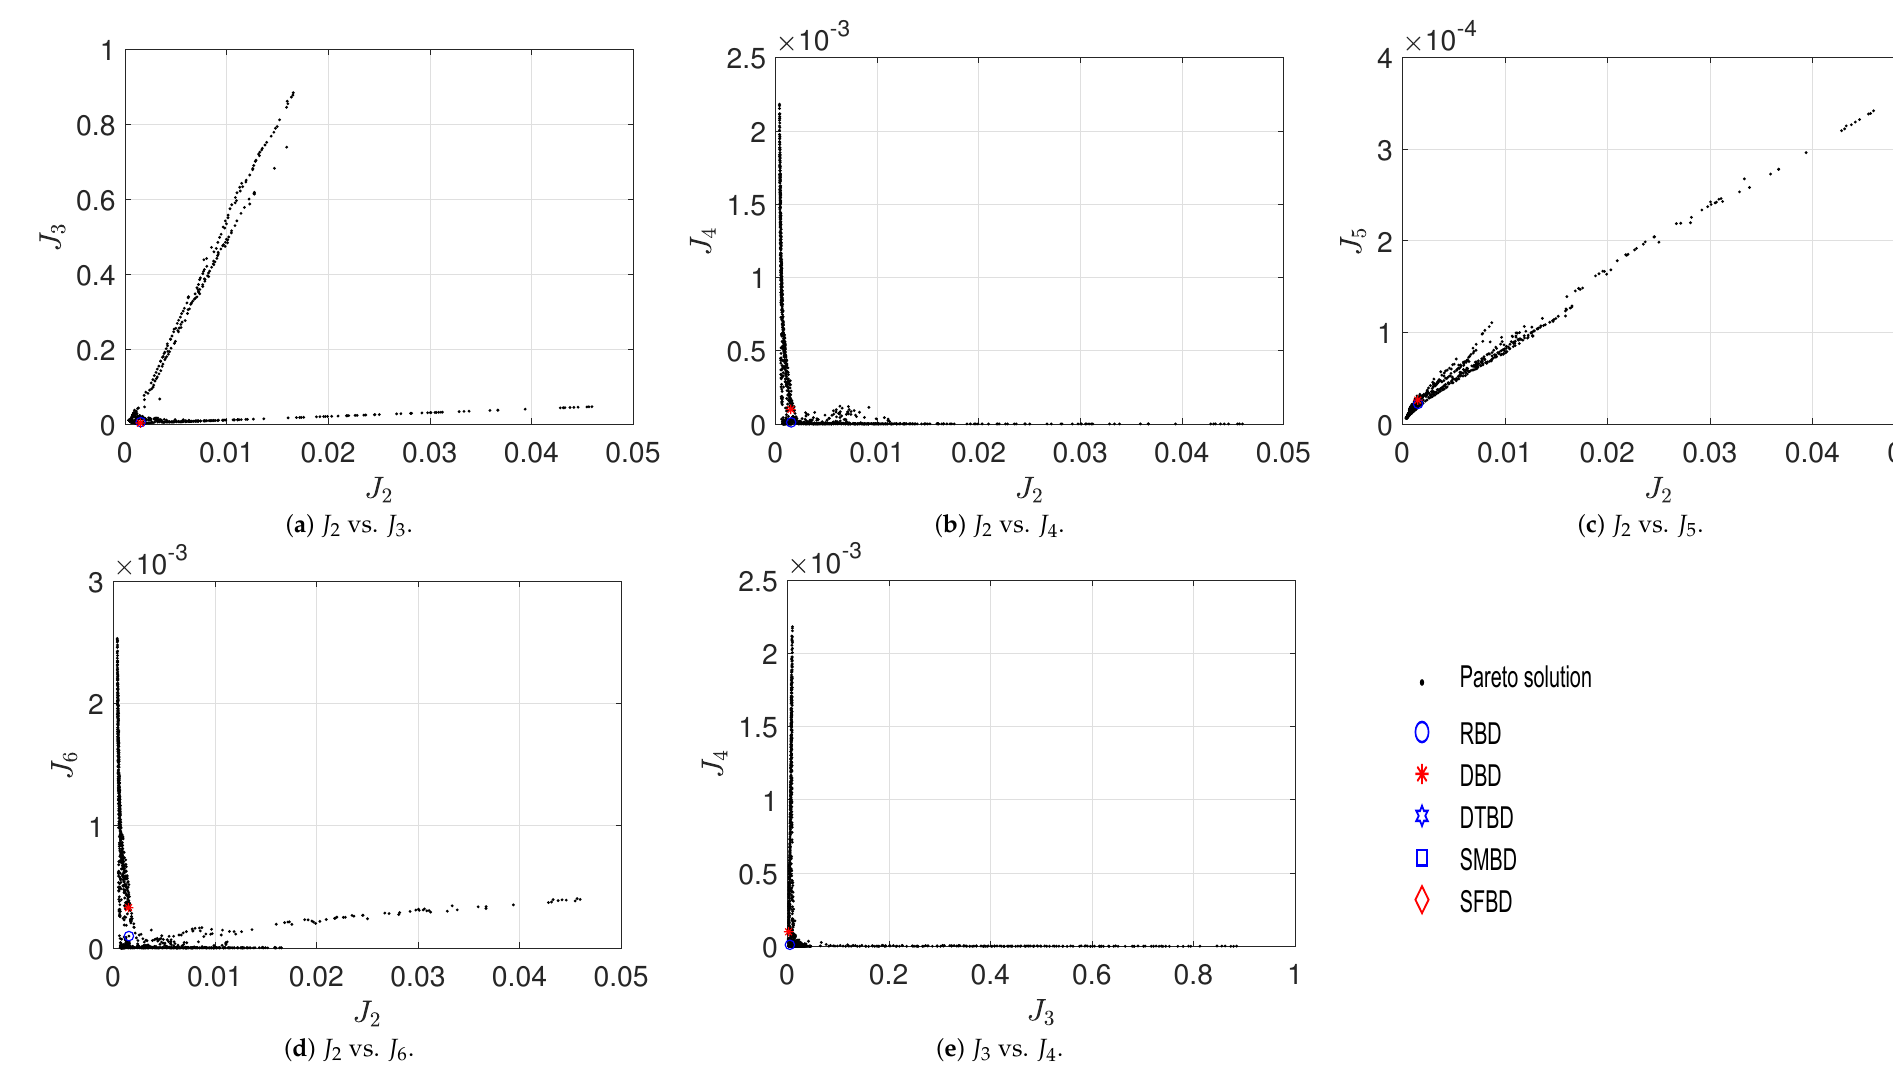
Figure 5. Pareto front in two-dimensional spaces